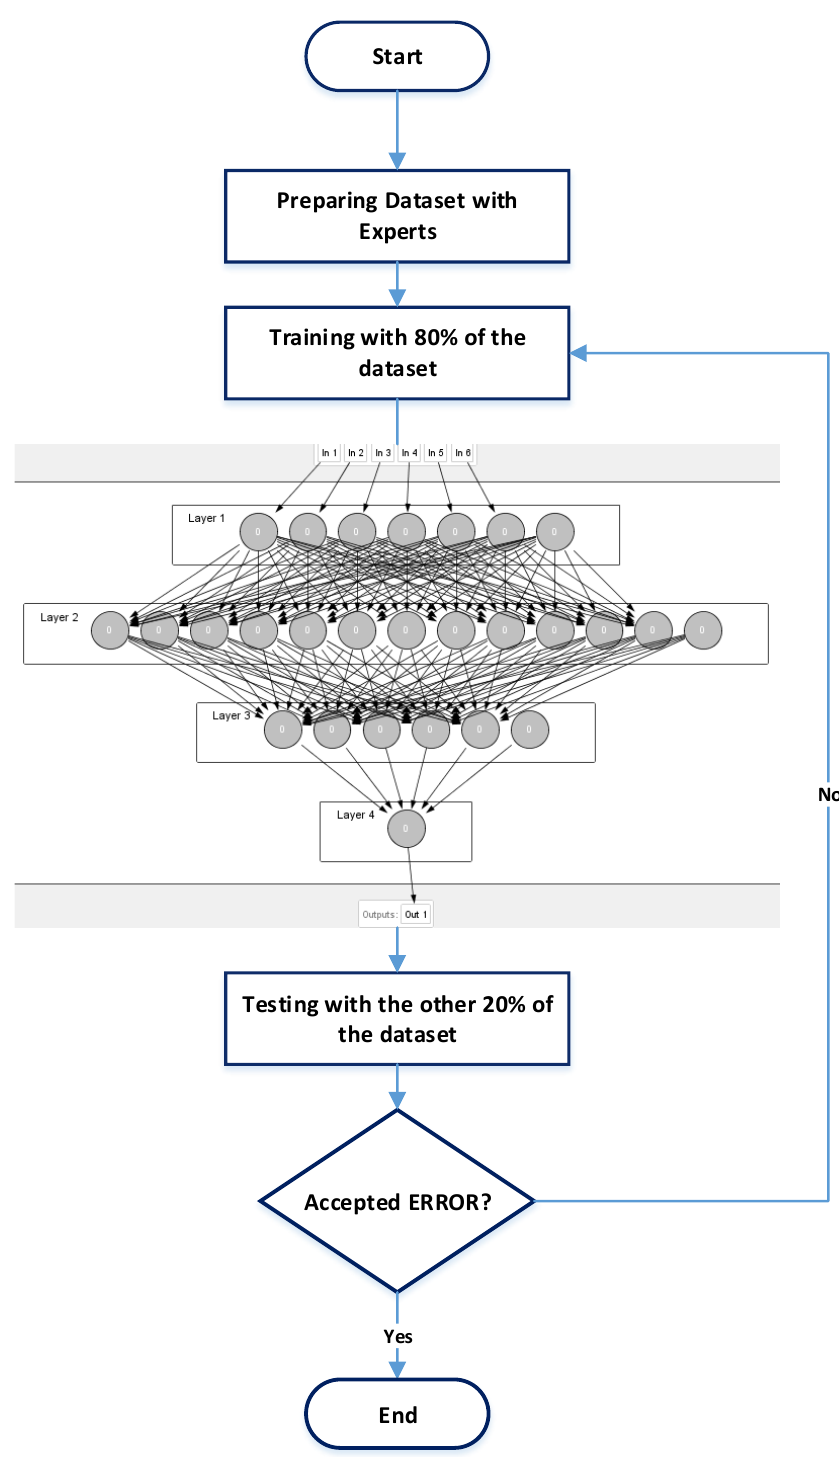
Figure 4. The learning process